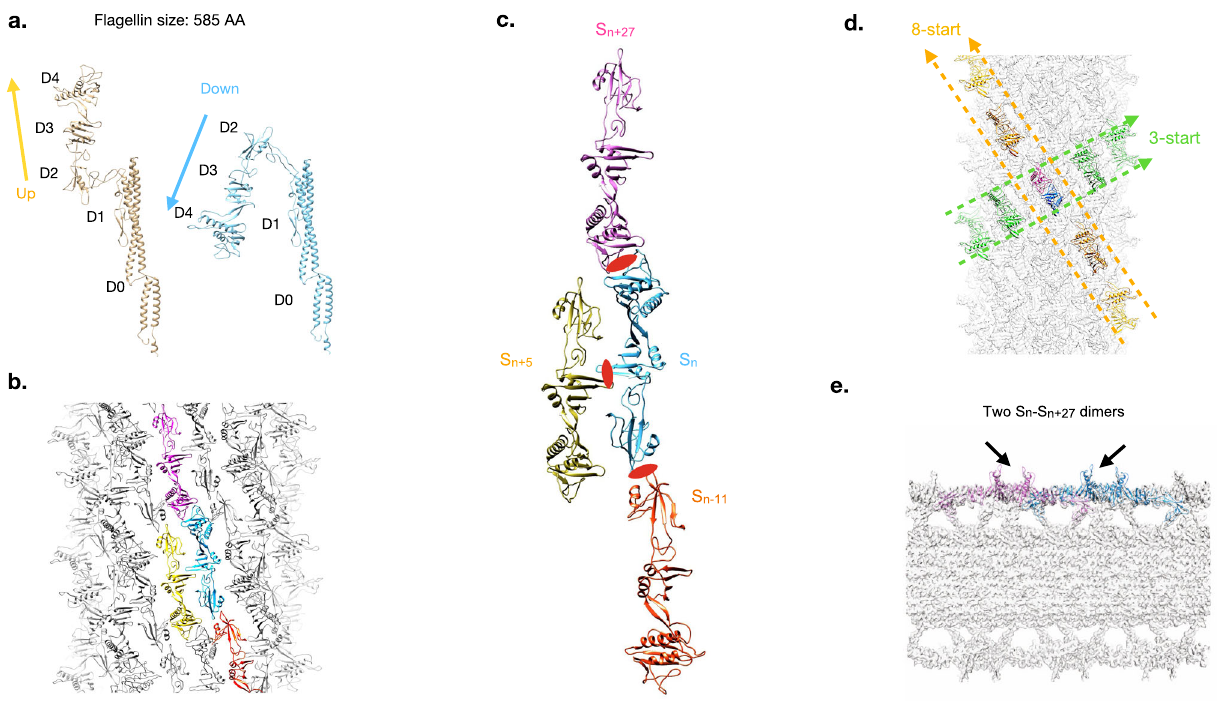
Fig. 3 Structural details of the dimeric EHEC O157:H7 fl agellar fi lament. a The two fl agellin conformations of the EHEC H7 fl agellar fi lament asymmetric unit. b Mesh-like sheath generated by interactions between four fl agellin outer domains (blue, pink, yellow, and orange). c The EHEC H7 outer domains from subunit S n interact with the outer domains of fl agellins that are 5 (S n + 5 ), 11 (S n + 11 ), and 27 (S n + 27 ) subunits away. d The S n :S n + 27 dimer generates prominent right-handed 3-start and left-handed 8-start helices in the sheath surrounding the core. e View of the EHEC H7 fl agellar fi lament cut halfway through the fi lament. The arrows are pointing to two S n :S n + 27 dimers, one blue and the other magenta, which are at the same radius.